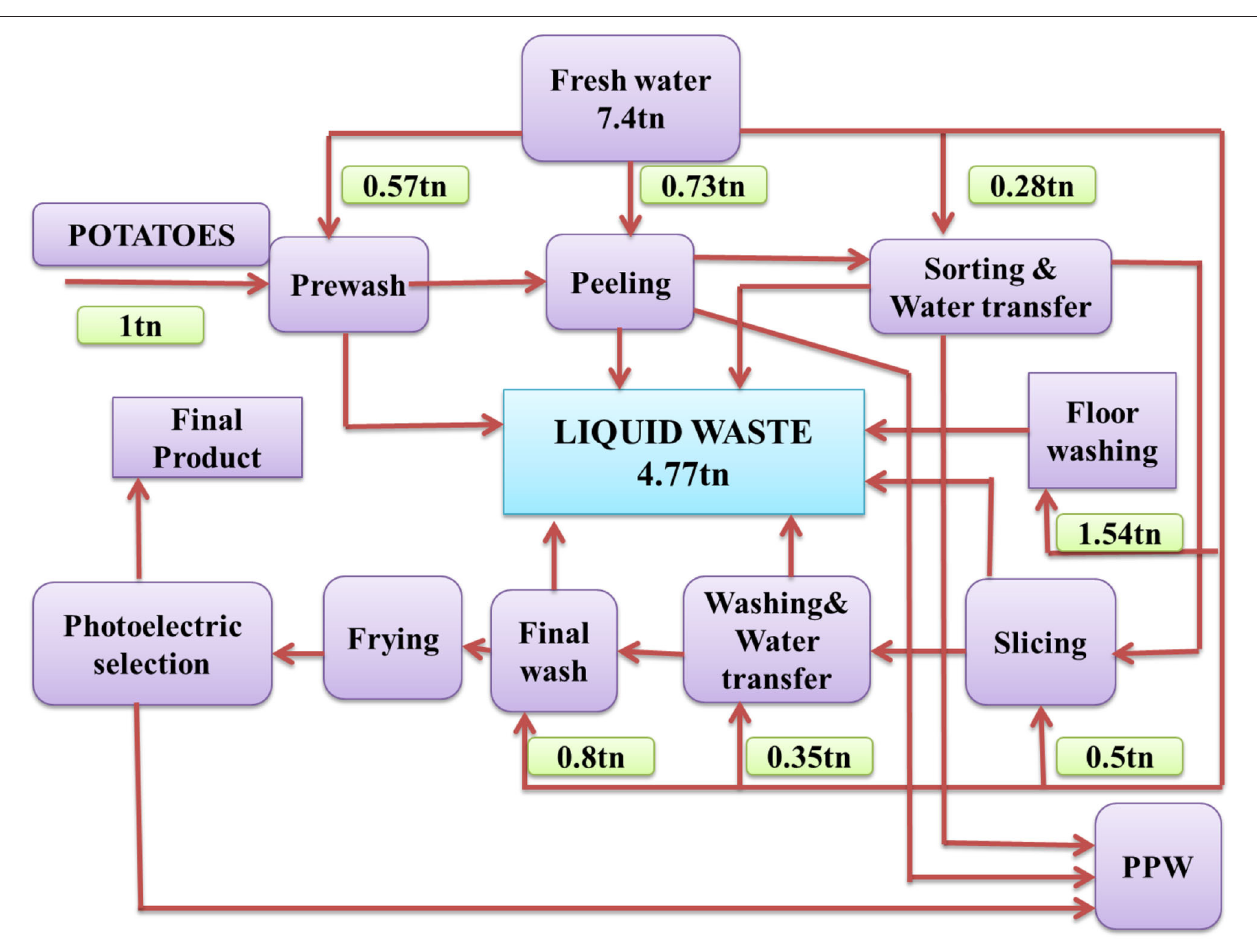
FIGURE 1 | Diagram showing potato chips manufacturing (Arapoglou et al.,